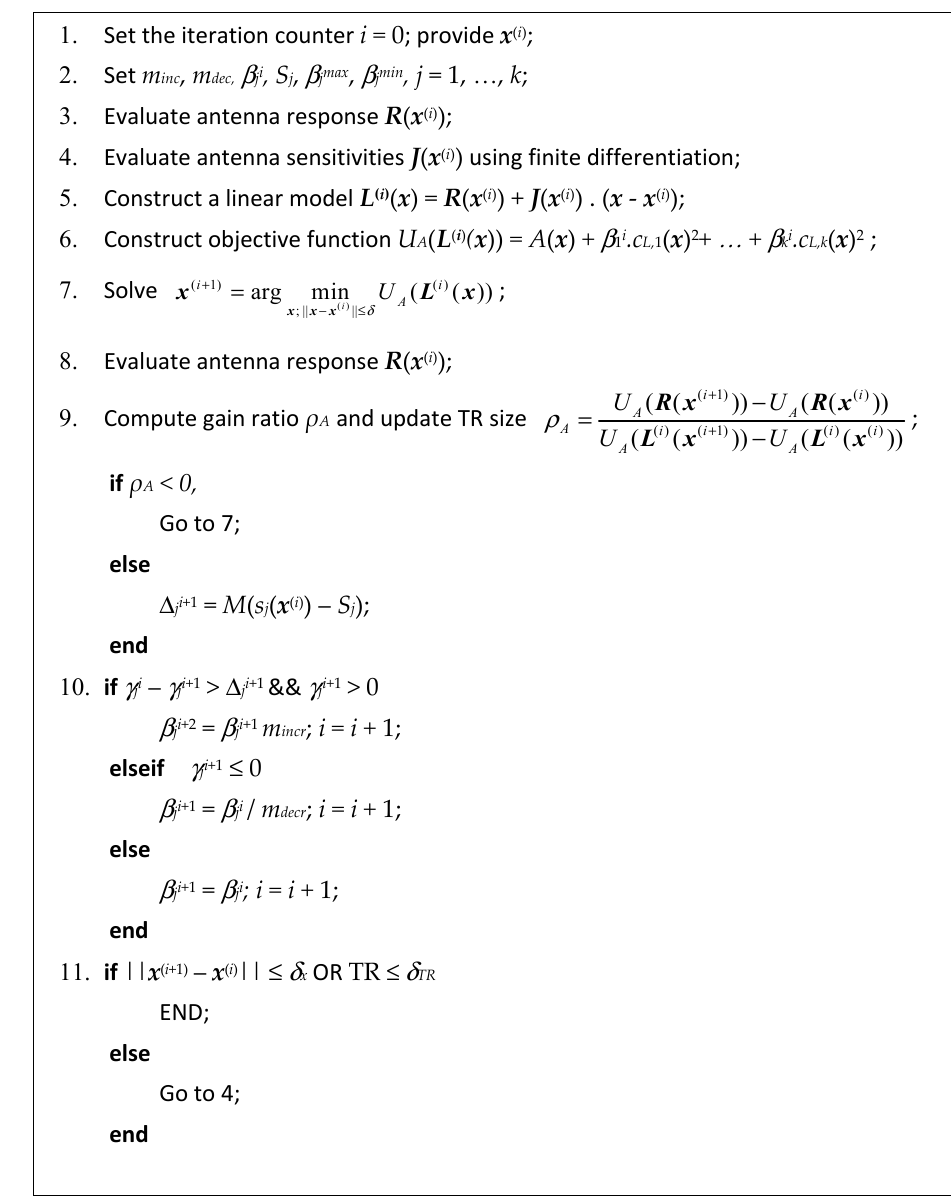
Figure 2. The concept of adaptive adjustment of penalty coefficients. Shown are the four possible situations concerning constraint violation, and the actions undertaken.